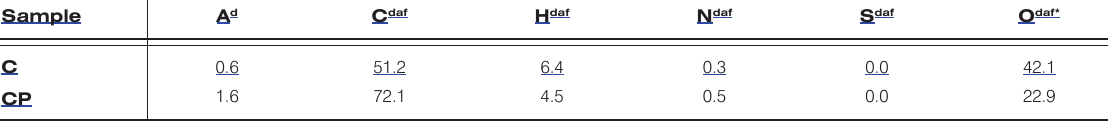
Table 1. Elemental analysis of initial sample and char obtained at 400ºC [wt.%]. Sample